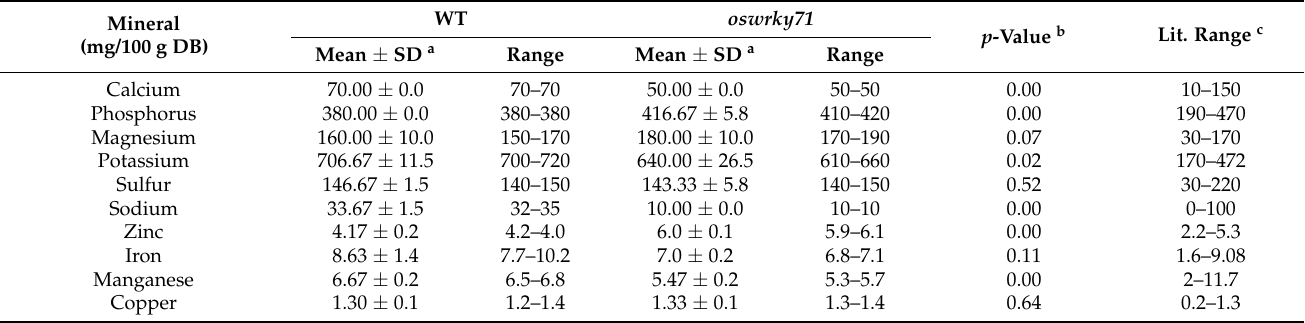
Table 2. Comparison of the mineral composition of threshed rice